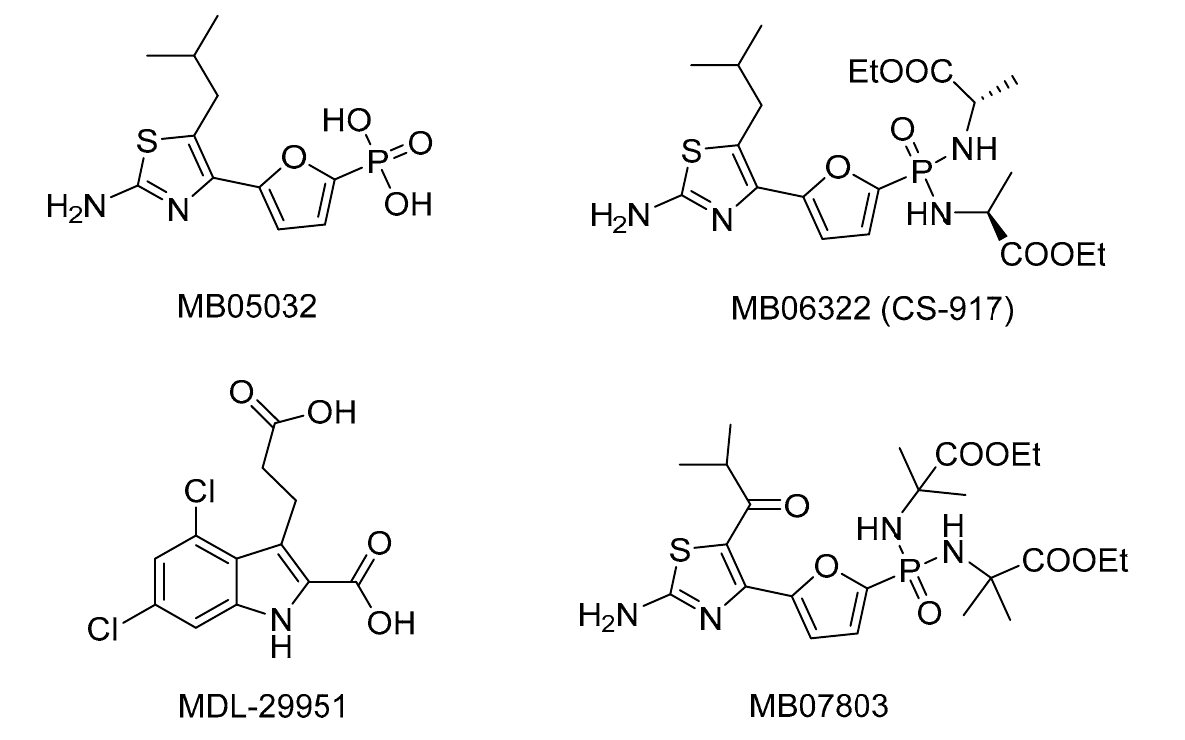
Figure 1. Chemical structures of representative FBPIs.